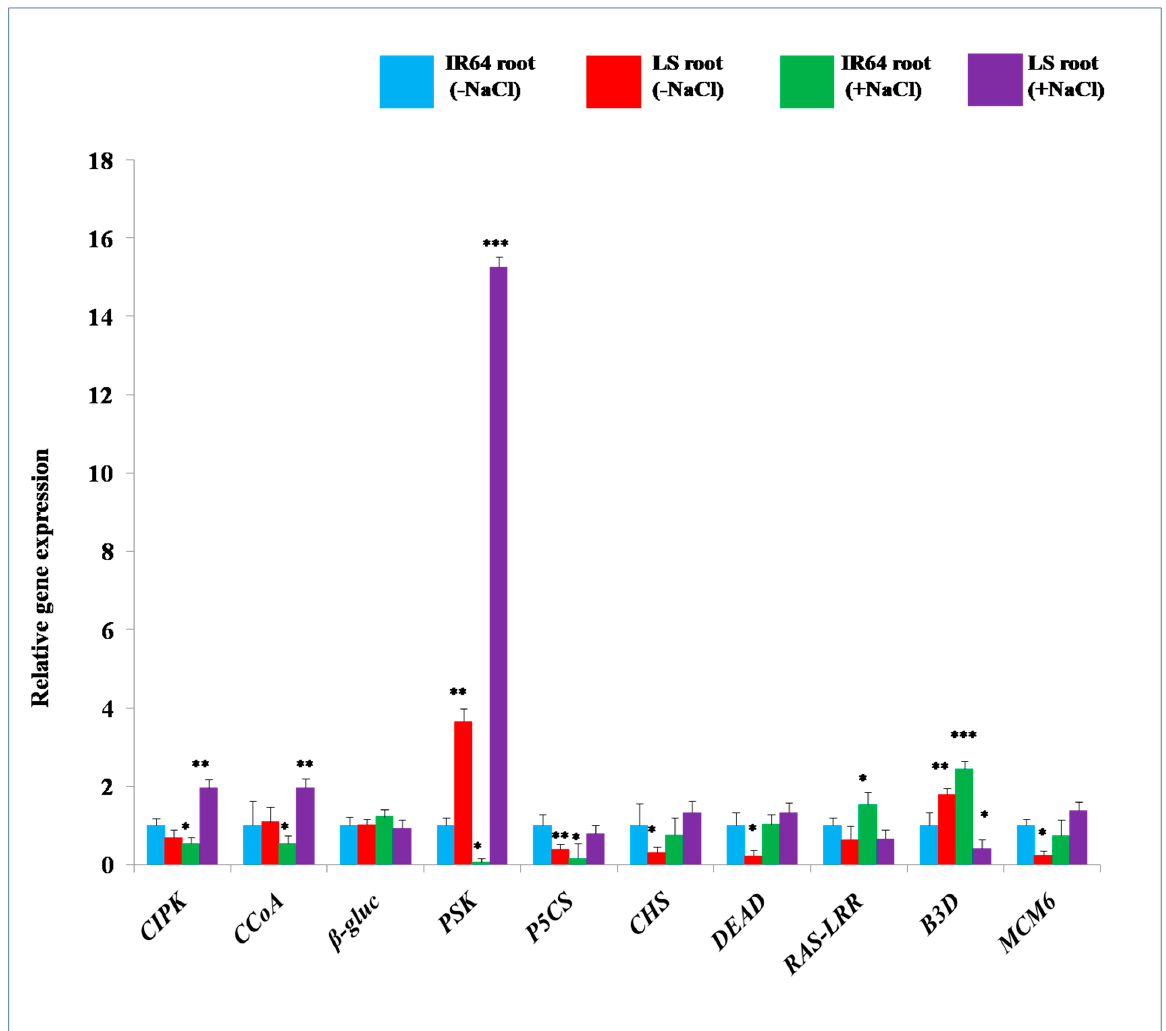
Figure 4. The relative expression levels of genes encoding for proteins differentially accumulated in IR64 and Luna Suvarna (LS) roots under control and salinity stress conditions. Three biological replicates were taken and bars represent mean ± SE. Asterisks signs (*, **, ***) represent values which were significantly different among different samples (Fisher LSD, p ≤ 0.05). The transcript levels of LS under normal condition and, LS and IR64 upon salinity stress treatment were compared with IR64 (control), whose expression was assumed as 1. (-NaCl) refers to untreated samples, (+NaCl) refers to salinity treated samples. Blue color refers to IR64 root (-NaCl), red color refers to LS root (-NaCl), green color refers to IR64 root (+NaCl) and purple color refers to LS root (+NaCl). CIPK: Calcineurin B-like interacting protein kinase 21; CCoA: 4-coumarate CoA ligase like 9; β -gluc: Beta-glucosidase 12; PSK: Phytosulfokines 3; P5CS: Delta-1-pyrroline-5-carboxylate synthase; CHS: Cyanate hydratase; DEAD: DEAD-box ATP-dependent RNA helicase 53; RAS-LRR: Plant intracellular Ras group related LRR protein 2; B3D: B3 domain-containing protein; MCM6: minichromosome maintenance